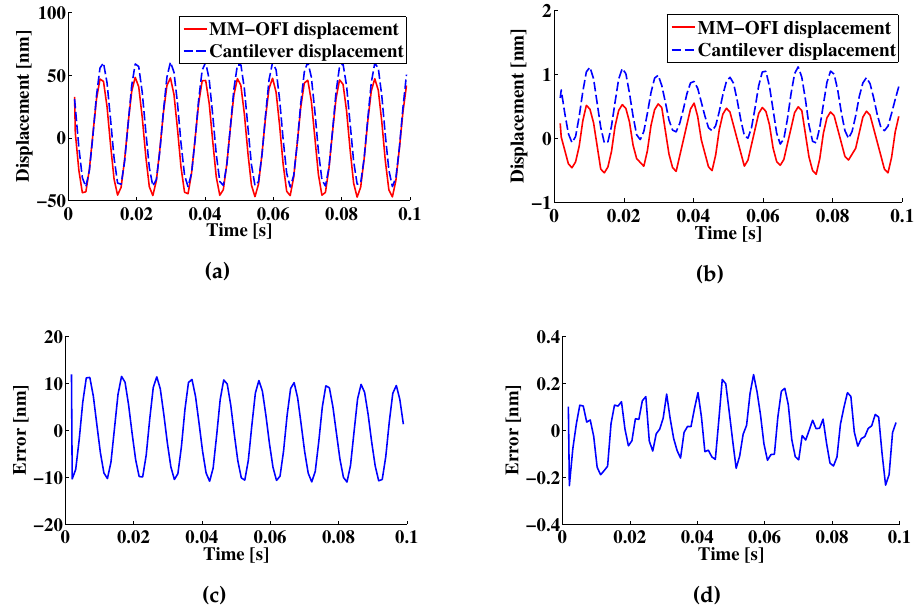
Figure 9. ( a , b ) Reconstructed displacements and ( c , d ) Reconstruction errors for a 100-nm and 1-nm amplitude displacements. In ( a ), a 10-nm offset is included on the 100 nm displacement for visibility purposes. Similarly, in ( b ), a 1-nm offset is included on the 1-nm displacement for visibility purposes. The legend MM-OFI is used to refer to the mechanically-modulated OFI signal.